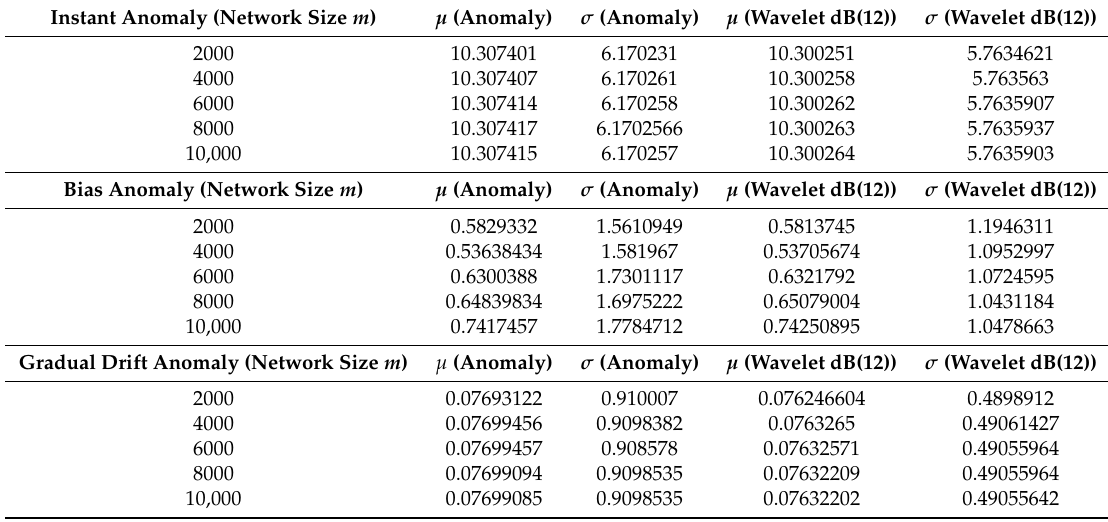
Table 1. Selected basic safety messages (BSMs) variables Descriptive